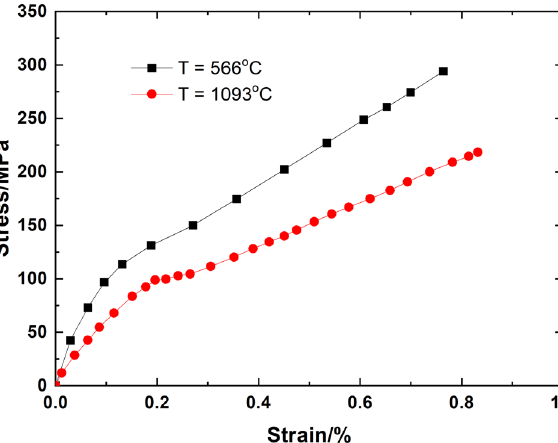
Figure 3: Tensile stress – strain curves of cross - ply SiC/MAS com - posite at 566°C and